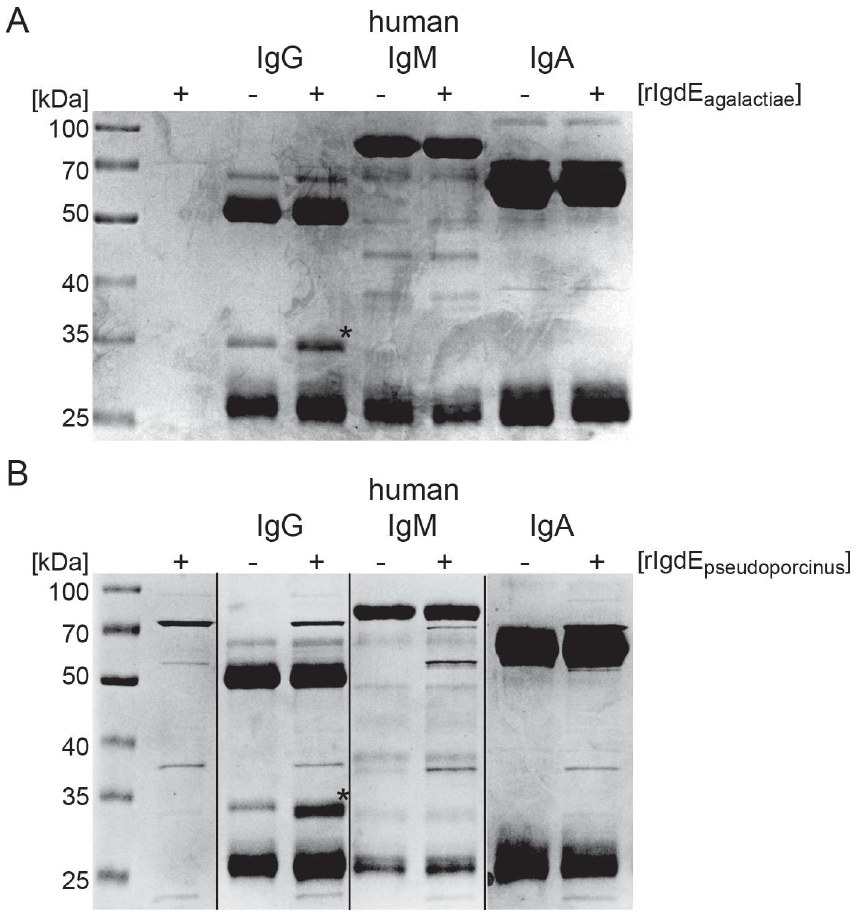
Fig 4. IgdE agalactiae and IgdE pseudoporcinus are specific for human IgG compared to IgM and IgA. 0.5 mg/ml human IgG, IgM and IgA were incubatedfor 16h at 37˚C with (+) or without (-) 20 μ g/ml purified rIgdE agalactiae (A) or 5% solublefraction of E. coli cells expressing rIgdE pseudoporcinus (B). Reactions were analyzedby SDS-PAGE under reducingconditions. SDS-PAGE was stained with Coomassieblue. Order of lanes within SDS-PAGE was